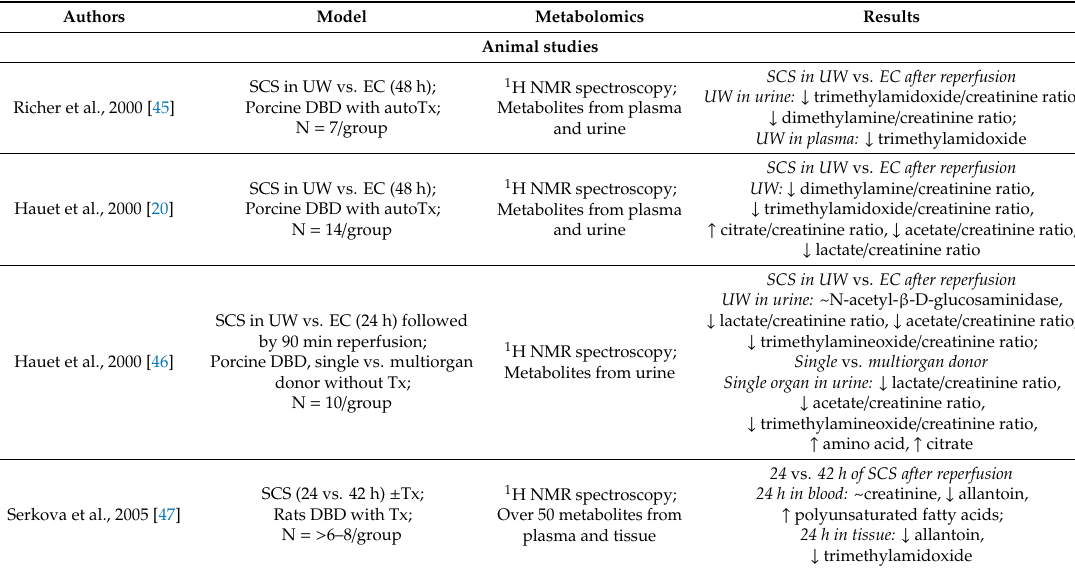
Table 3. Metabolomics in kidney preservation for